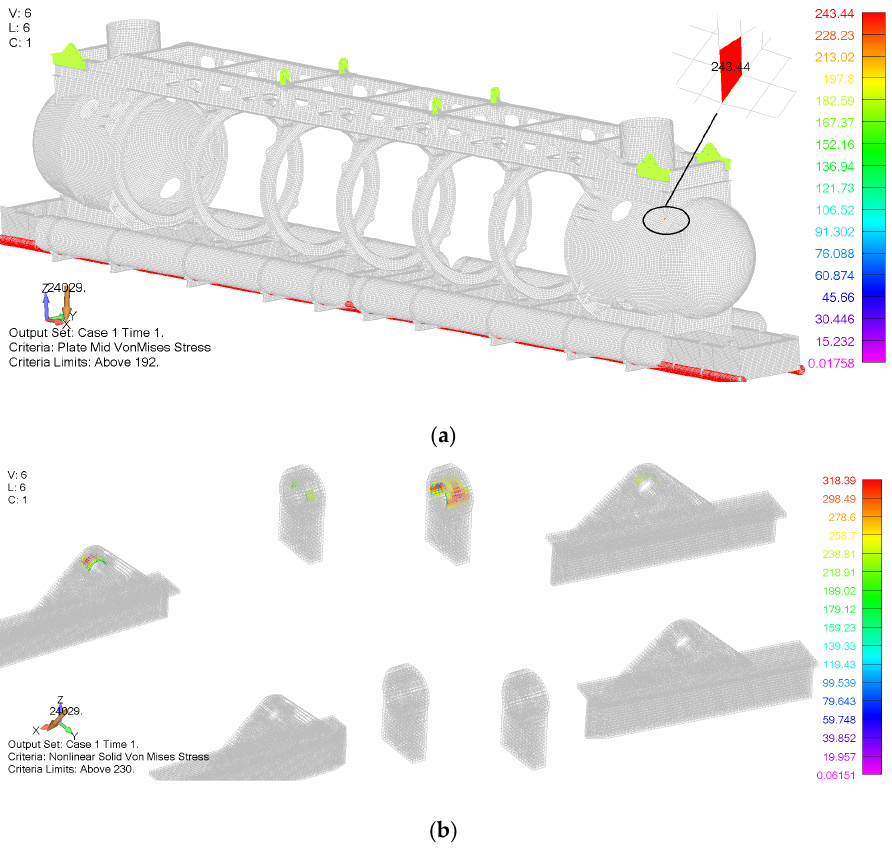
Figure 18. High-stress area in lugs for launching/recovering in rough seas: ( a ) plate elements with mid-plate von Mises stress above 192 MPa; and ( b ) solid elements with von Mises stresses above 230 MPa.